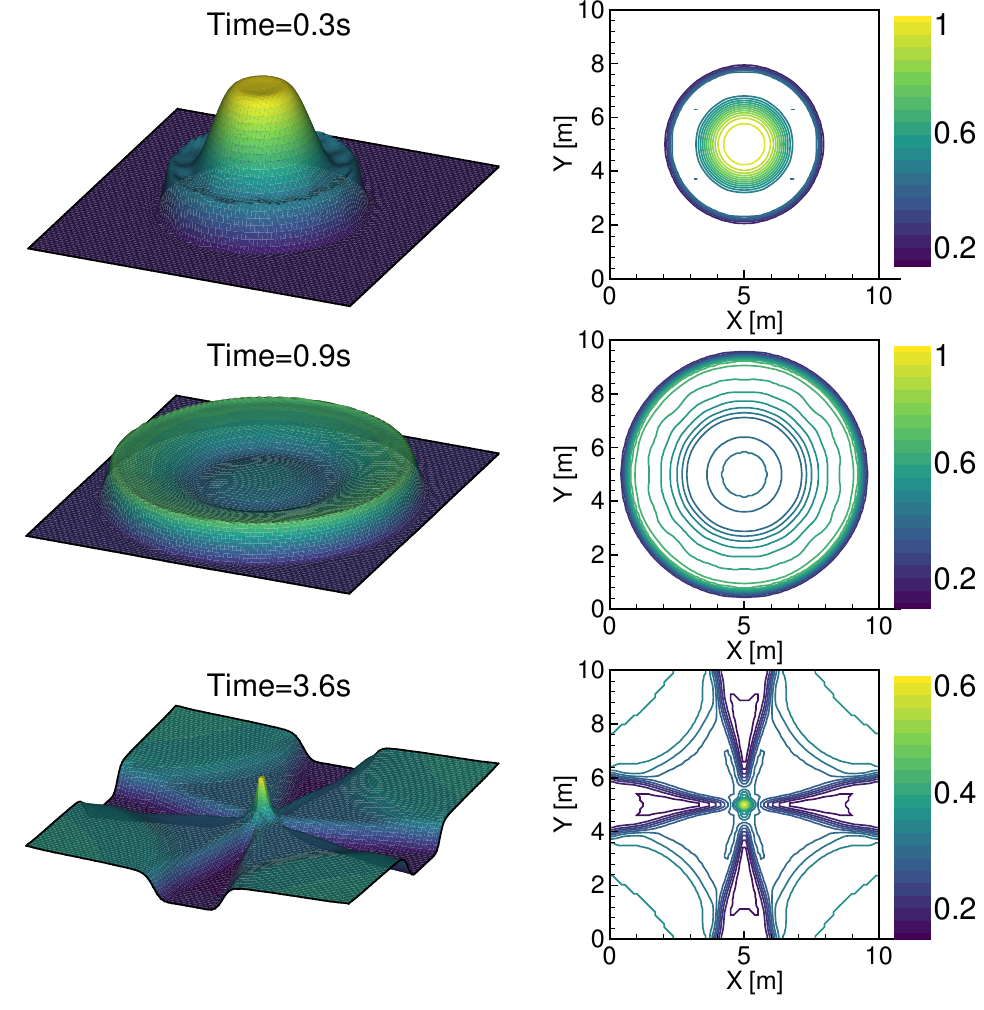
Figure 2. Water level calculated after the dam break at times t = 0.3 s, 0.9 s and 3.6 s. On the right, a three-dimensional view, and on the left, the water level